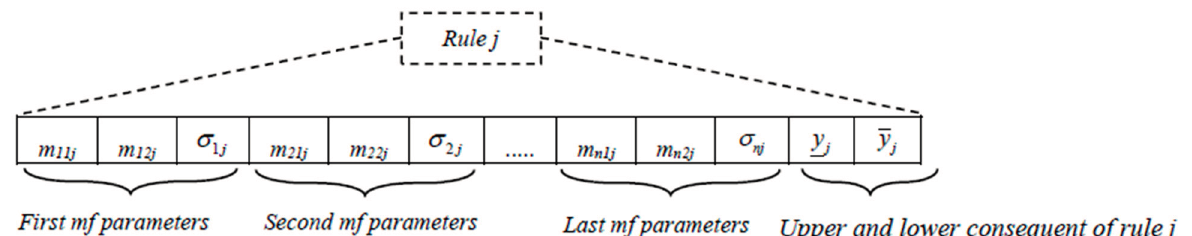
Figure 5. Scheme coding of a FLS through the CCL.